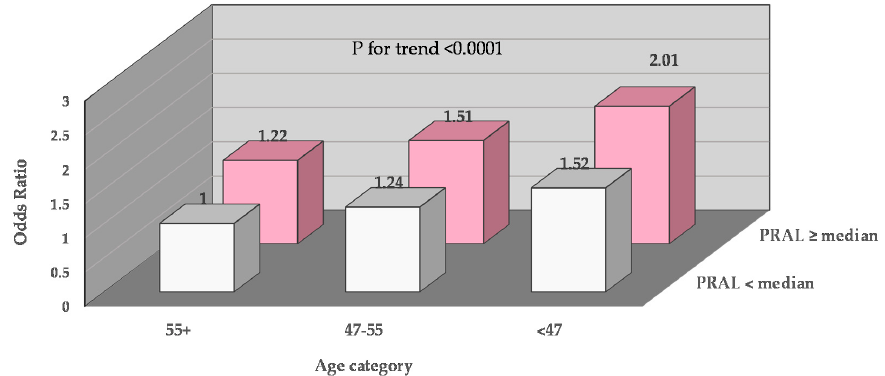
Figure 1. Joint associations of PRAL and age with depression. Covariates in the multivariable model included the body mass index, physical activity, living alone status, menopausal status at baseline, number of comorbidities at baseline, total calorie intake, and intakes of vitamin B12. Abbreviations: PRAL: potential renal acid load.